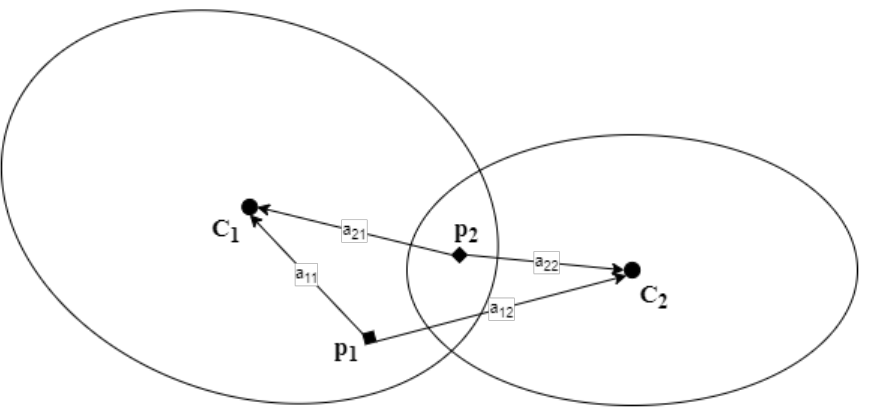
Figure 3. Affinity between data points and class representatives, where k = 2 and n =